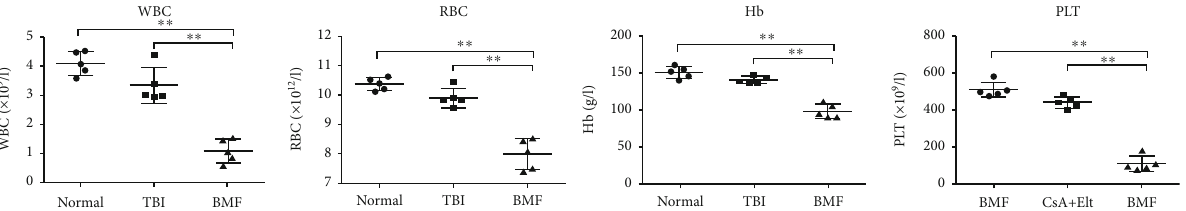
Figure 1: The complete blood counts of the AA mice were lower compared with the NC and TBI groups. ∗ P < 0 : 05 ; ∗∗ P < 0 : 01 .